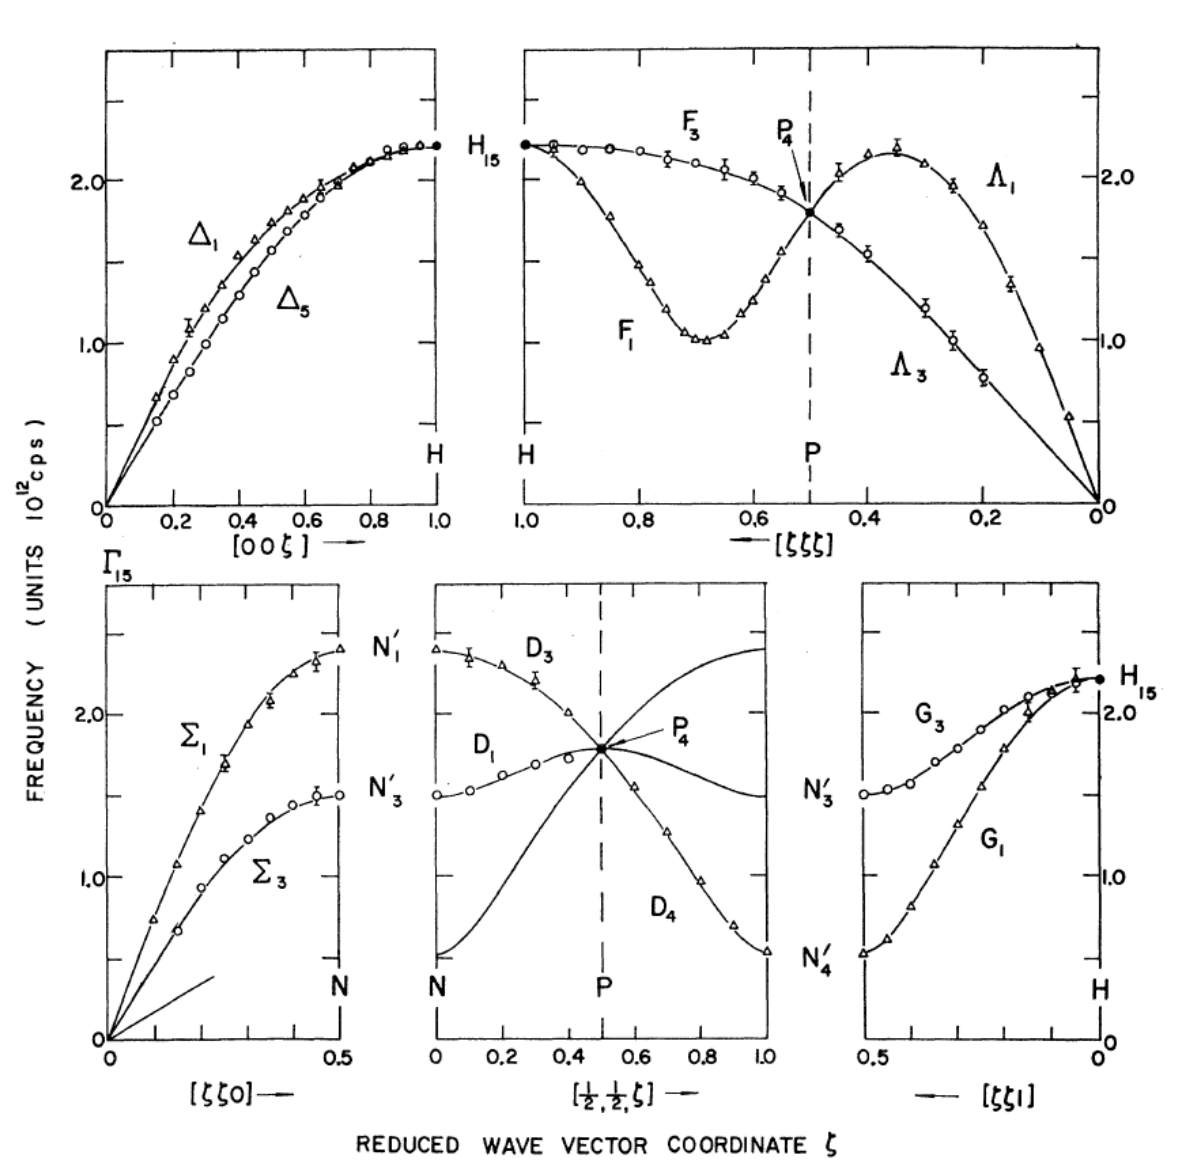
Figure 24. The phonon dispersion relations in body-centered cubic potassium at 9 K. ζ , expressed in units of 2 π /a, is a reduced wavevector coordinate. In the [00 ζ ], [ ζζ 0], and [ ζζζ ] directions, transverse (longitudinal) modes of vibration are denoted by circles (triangles). The solid curves represent the best fit to the results on the basis of a Born–von Kármán model with axially symmetric forces extending to fifth nearest-neighbor atoms. This figure is taken from Figure 1 of ref. [65]. Copyright by the American Physical Society.